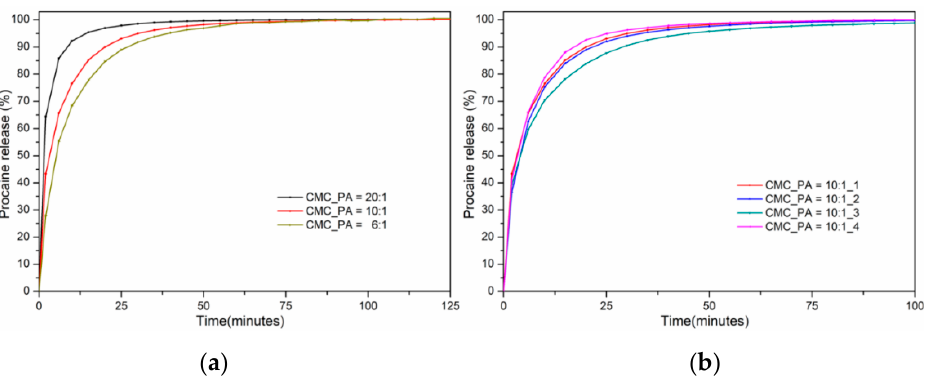
Figure 7. Procaine release profiles from the investigated hydrogels with different compositions ( a ) and different drug concentrations ( b ). and different drug concentrations ( b